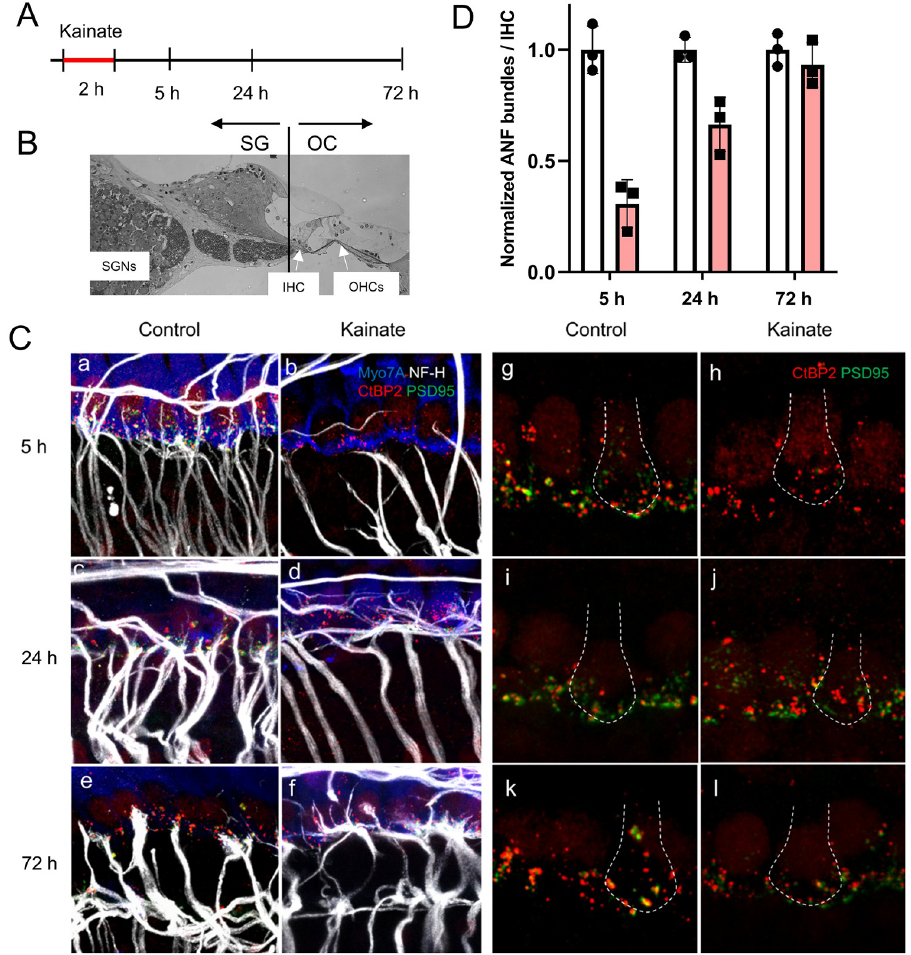
Fig 1. Synaptic regeneration in cochlear explants after kainate treatment. (A) Timeline of experimental procedure. (B) A cochlear cross section showing the plane of microdissection separating the spiral ganglion (SG) fraction from the Organ of Corti (OC) fraction. (C) The afferent nerve fibers of spiral ganglion neurons, seen with immunostaining for neurofilament (in white), have synapses with hair cells, as revealed by immunostaining for PSD-95 (in green) and CtBP2 (in red) under each hair cell, stained with Myo7A (in blue), after 5 h in culture (Control). Treatment of the mouse cochlea with kainate for 2 hours resulted in massive loss of the peripheral processes and post-synaptic densities of spiral ganglion neurons by 5 h (Kainate). By 24 h, the peripheral processes had grown and formed synapses (characterized by juxtaposition of CtBP2 and PSD-95 immunostaining) with hair cells (Kainate). At 72 h, there was fiber loss in both the control and treated (Kainate) cultures. Panels a-f highlight auditory nerve fibers. Panels g-l highlight synapses; the white dotted line in each panel outlines a hair cell. Scale bars 20 μ m. (D) Quantification of auditory nerve fiber (ANF) bundles per inner hair cell after kainate treatment (red bars) normalized to untreated samples (white bars) at the same time point. Data are presented as means ± SD per group. N = 3 explants per